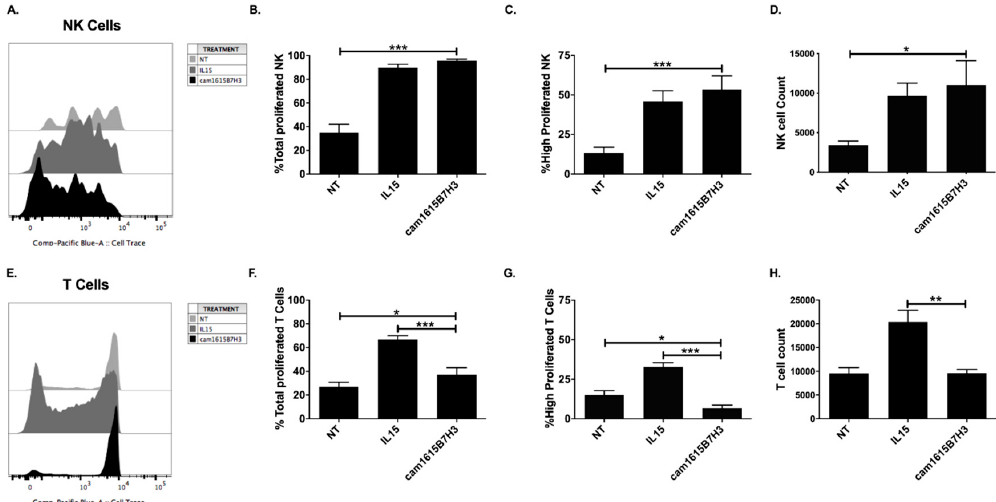
Figure 2. cam1615B7H3 TriKE induces potent, and specific, natural killer (NK) cell proliferation. Peripheral blood mononuclear cells (PBMCs) were CellTrace Violet labeled and incubated for seven days at 5 nM equimolar concentrations of rhIL-15 or cam1615B7H3 TriKE. On day 7, the cells were harvested and stained for flow cytometric evaluation. ( A ) A representative histogram showing NK cell (CD56 + CD3 − ) proliferation measured as the dilution of the CellTrace Violet dye. Pooled data showing ( B ) the overall proportion of NK cells that proliferated or ( C ) the proportion of NK cells that highly proliferated (measured as proliferation beyond three divisions), as well as ( D ) NK cell counts in the cultures (N = 9). In comparison, ( E ) a representative histogram showing T cell (CD56 − CD3 + ) proliferation. ( F ) Pooled data showing the overall proportion of T cells proliferated or ( G ) the proportion of T cells highly proliferated, as well as ( H ) T cell counts in the cultures (N = 9). * p < 0.05, ** p < 0.01, *** p < 0.001.